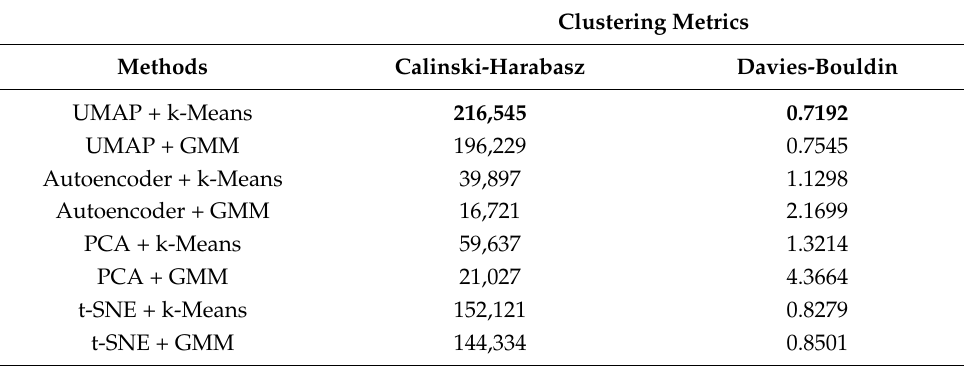
Table A2. Mean of the Calinski-Harabasz and Davies-Bouldin criterion over a range of 5 to 20 clusters for the FRT0000b776 dataset, split by method. The best score for each coefficient is in bold.